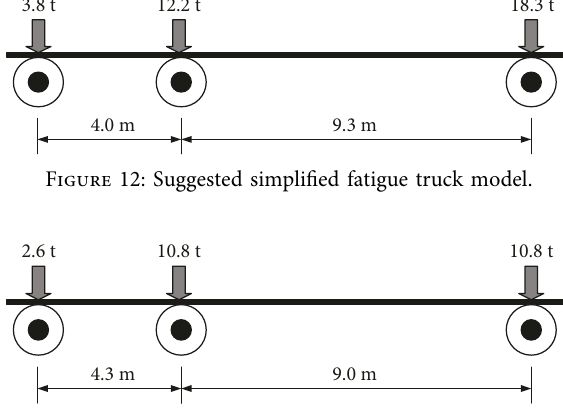
Figure 13: Simplified standard fatigue truck model of AASHTO LRFD.